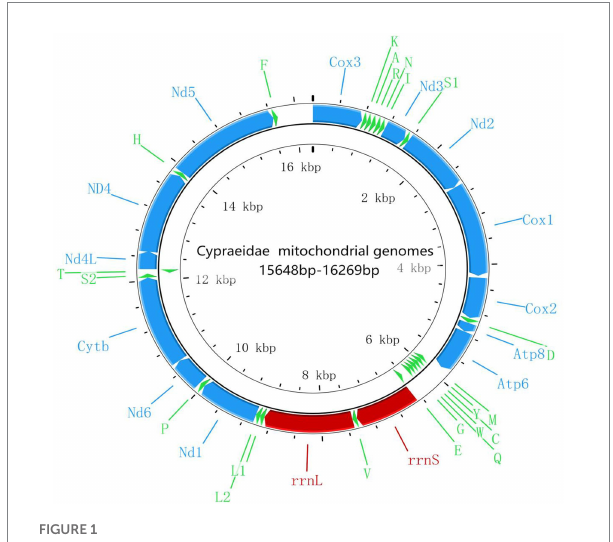
FIGURE 1 Gene map of the mt genomes of